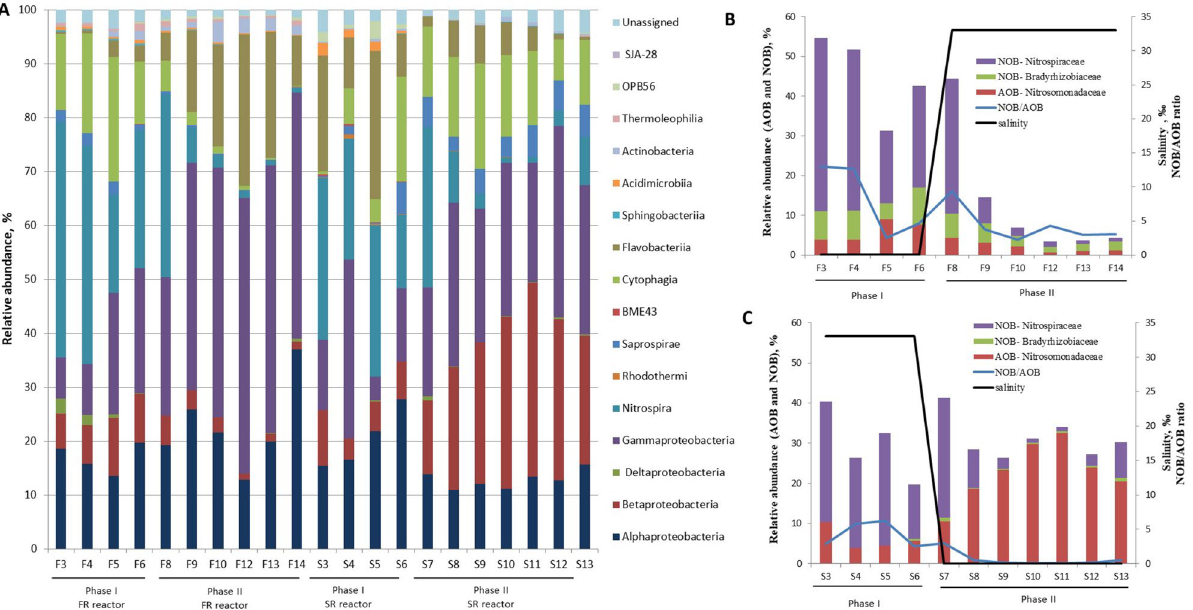
Figure 2. ( A ) Relative abundance per sample of the different classes in the samples. For freshwater reactor (FR), F3–F14 samples in phase I and II with freshwater and seawater environment, respectively. For seawater reactor (SR), S3–S13 samples in phase I and II with seawater and freshwater environment, respectively. ( B , C ) Average relative abundances at family level of the AOB and NOB guilds, the NOB/AOB ratio and the salinity for FR reactor ( B ) and SR reactor ( C